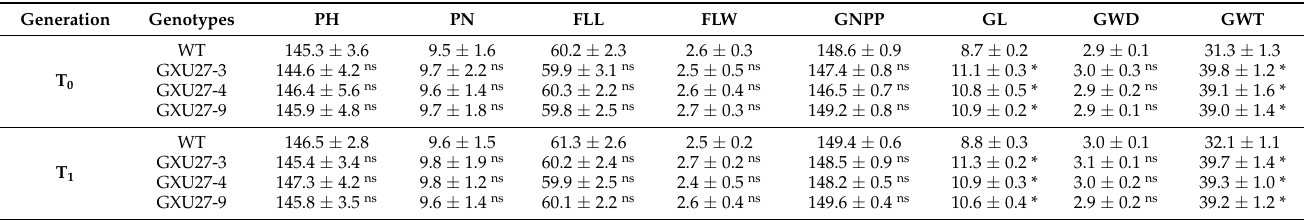
Figure 3. ( A ) Plant type and ( B ) grain phenotype of wild type (WT) and mutants (GXU27-3, GXU27-4, and GXU27-9) in the T 1 generation. Table 1. Increased yield of mutant lines in T 0 , T 1 , and T 2